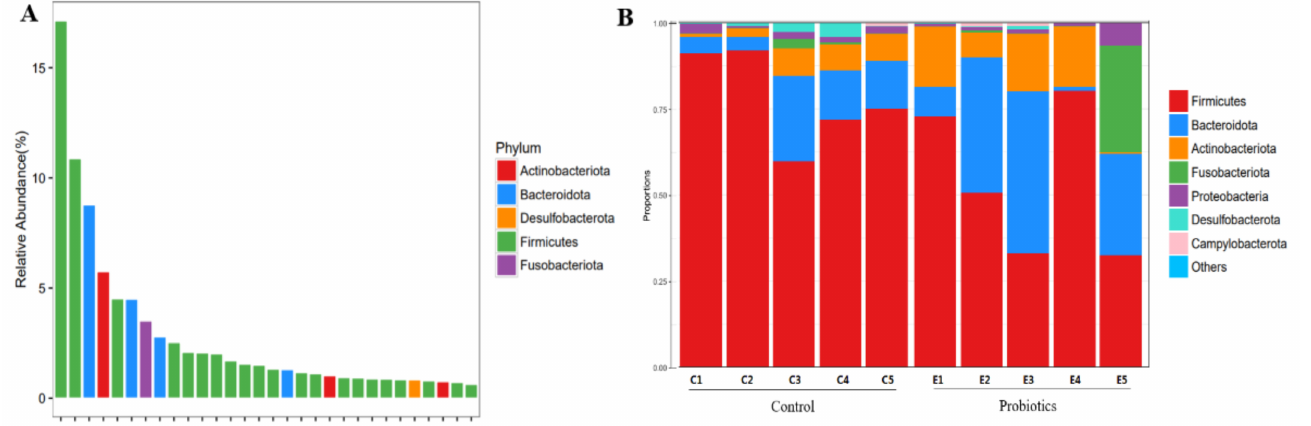
Figure 2. Phylum-level structural analysis. ( A ) The 30 most dominant species in all samples. ( B ) Relative abundance of the gut microbiota at the phylum